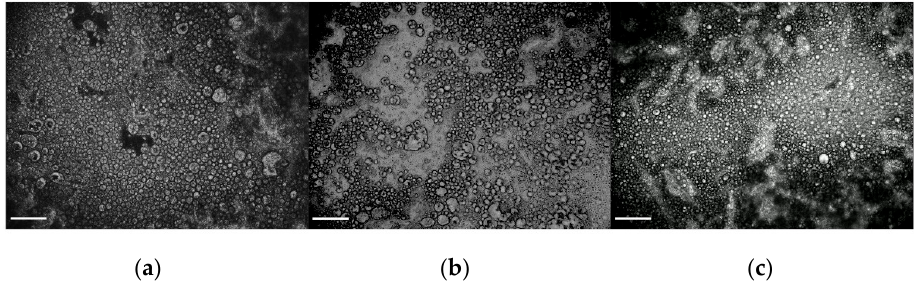
Figure 7. Contrast phase micrographs for samples E2.3.1.20 ( a ), E2.3.3.20 ( b ) and E2.3.3.30 ( c ); magnification 20×; reference bar corresponds to 100 µm.